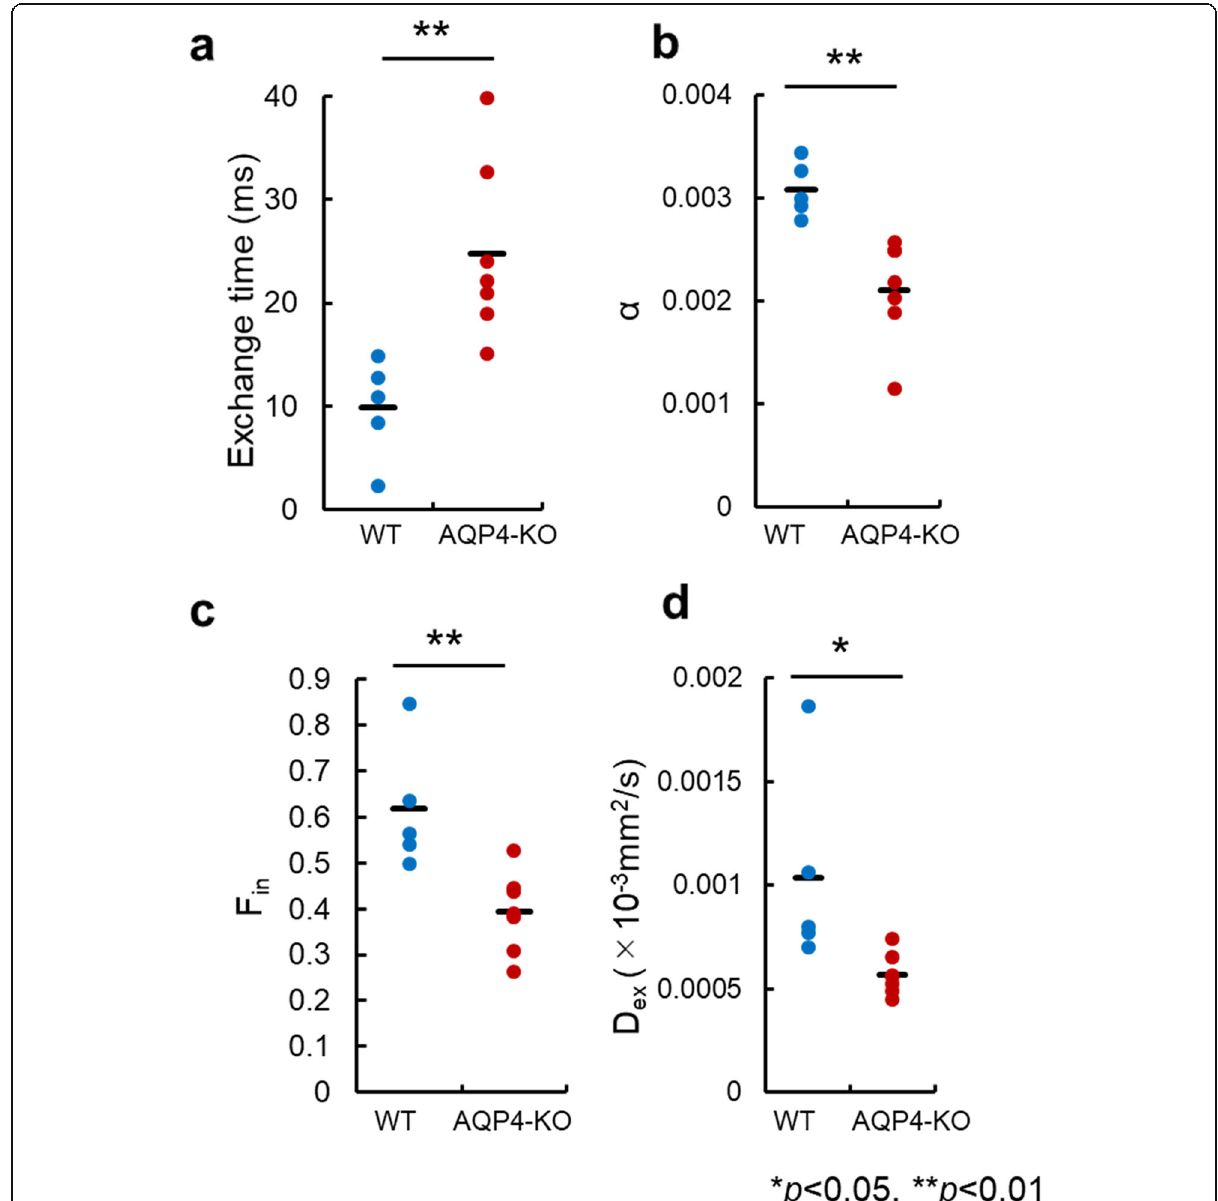
Fig. 4 Estimates of the exchange model parameters in the ischemic region. The exchange model parameters were estimated by fitting to the diffusion-weighted imaging data in the ischemic region. Exchange-time ( a ), water exchange time between the intracellular and extracellular space; α ( b ), a parameter reflecting the mean cell volume; F in ( c ), signal fraction from intracellular space. D ex ( d ), apparent diffusion coefficient for the extracellular space. The plots show the mean for each wild-type (WT) (blue) and aquaporin-4 knockout (AQP4-KO) (red) mouse, while the black bars correspond to the mean over animals. * and ** indicate significant differences in the estimates from the WT and AQP4-KO mice ( a , p = 0.006; b , p = 0.003; c , p = 0.004; d , p = 0.044; unpaired t test) Table 1 Two-way ANOVA results ( F values and p values) for the ADC on the ipsilateral side b value (s/mm 2